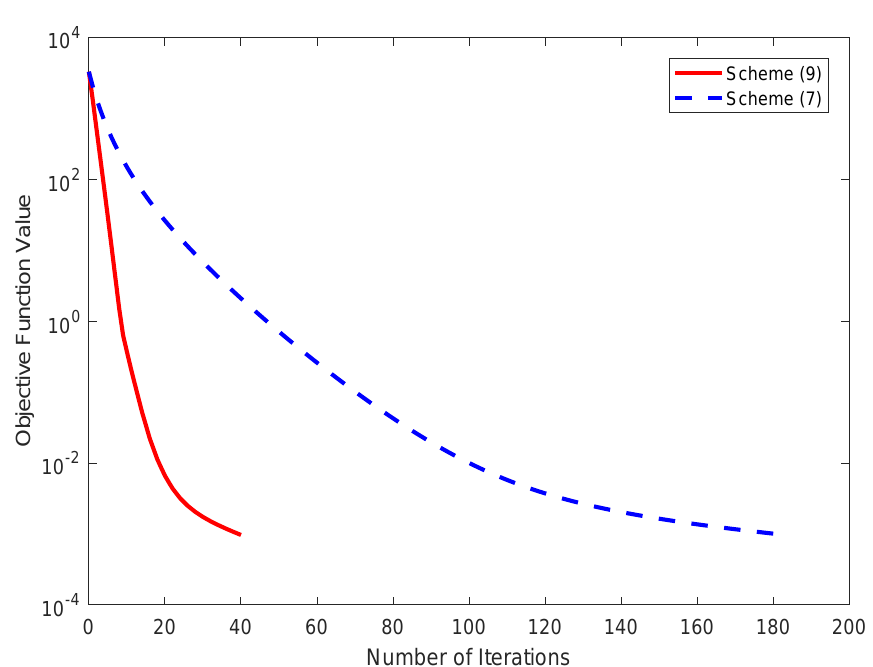
Figure 2. Comparison of scheme (9) and scheme (7) in Example 2, with ( m , s , p ) = ( 240,1024,30 ) .